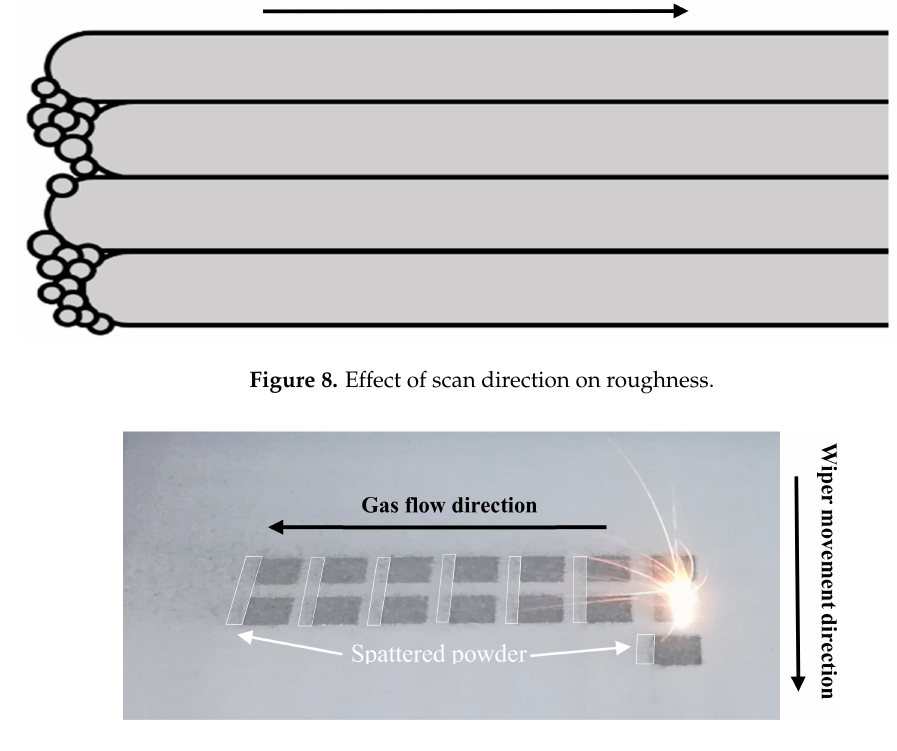
Figure 9. Effect of gas flow direction on